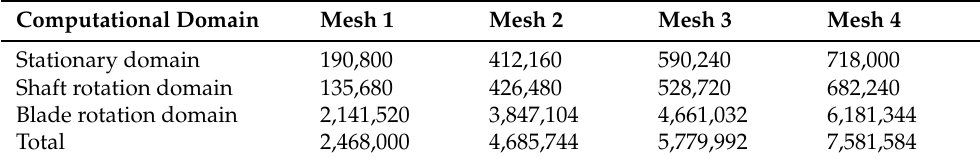
Table 3. Number of Three-dimensional meshs.